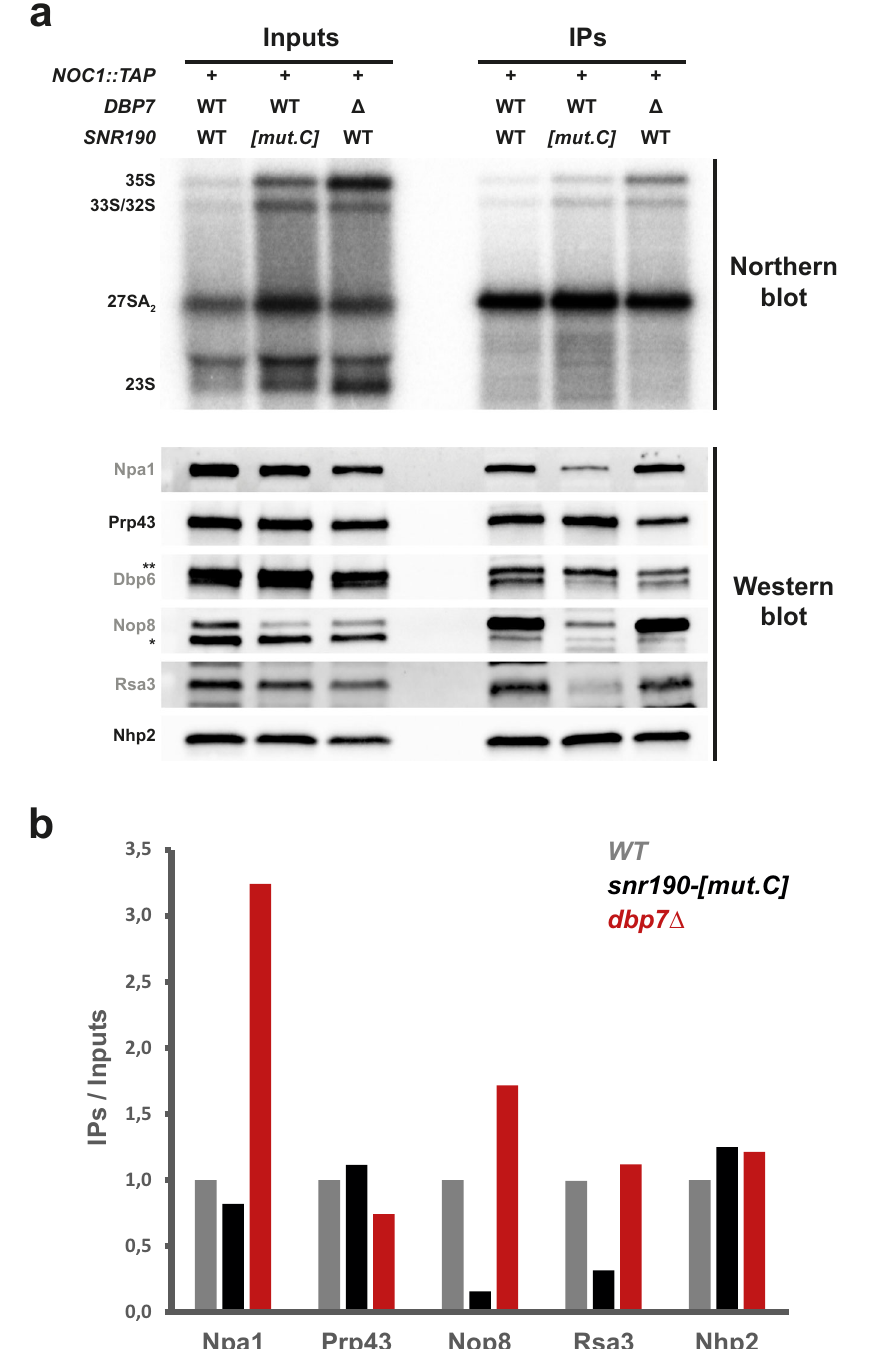
Fig. 8 snR190 is required for stable incorporation of the Npa1 complex into preribosomes. a Immunoprecipitation of Noc1-TAP-containing preribosomal particles from wild-type, snr190-[mut.C] and dbp7 Δ mutant strains, and analysis of their RNA and protein contents by northern and western blotting, respectively. Particles were immunoprecipitated from total cell extracts prepared from wild-type, snr190-[mut.C] , and dbp7 Δ strains expressing a TAP- tagged version of Noc1. Pre-rRNA components of 90S and early pre-60S r-particles (indicated on the left) present in the total extracts (Inputs) or in the immuno-precipitates (IPs) were analyzed by northern blotting (upper panel) using a radiolabeled probe (Supplementary Table 4). Protein levels of components of the Npa1 complex (indicated in grey) or other proteins present in early preribosomal particles (labeled in black) were analyzed by western blotting on the Input or IP samples (lower panel) using speci fi c antibodies. *: nonspeci fi c signal detected with the anti-Nop8 antibodies. **: Prp43 signal resulting from incubation of the membrane with anti-Prp43 antibodies (see above panel) prior to incubation with anti-Dbp6 antibodies. b Quanti fi cation of the western blot signals obtained in a . Western blot signals were quanti fi ed from ChemiDoc images (Biorad) using the Image Lab software (Biorad). The histogram represents the co-immunoprecipitation ef fi ciencies (IPs over Inputs) of the indicated proteins with Noc1-TAP in the wild-type ( WT , gray), snr190-[mut.C] (black), and dbp7 Δ (red) strains, normalized with respect to the ratios in the wild-type strain. Note: the Dbp6 signal obtained in a could not be quanti fi ed accurately due to the proximity of the Prp43